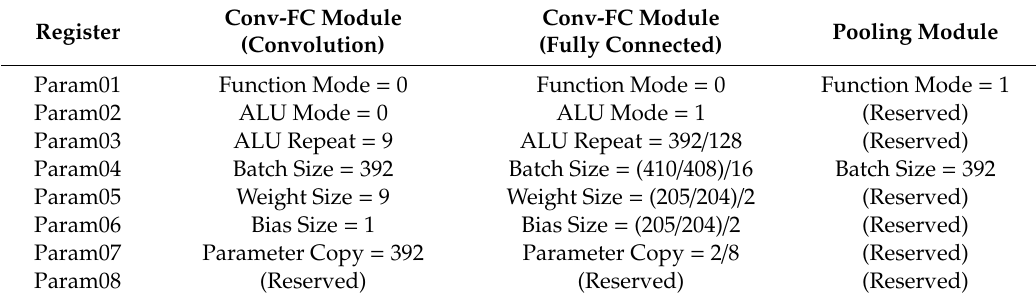
Figure 16. Format of input data stream. Table 7. Decoding results of each acceleration